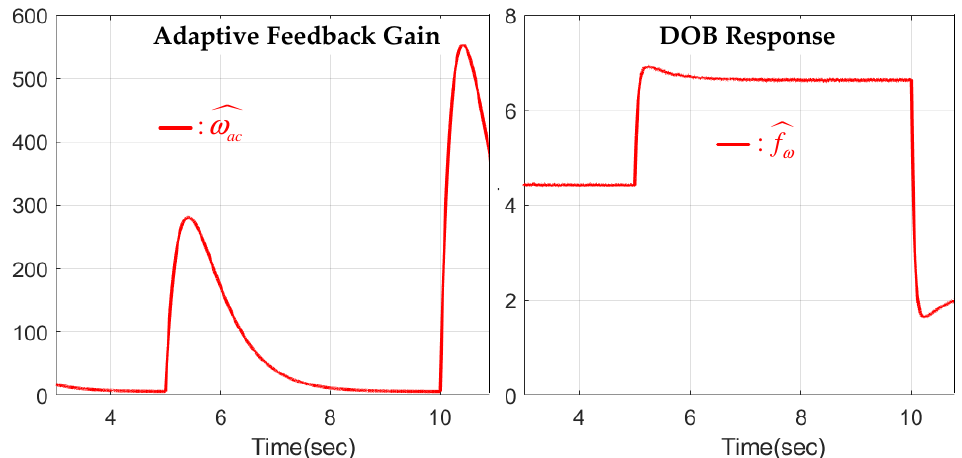
Figure 4. Comparison of adaptive feedback gain and DOB responses in stair speed reference track- ing mode.